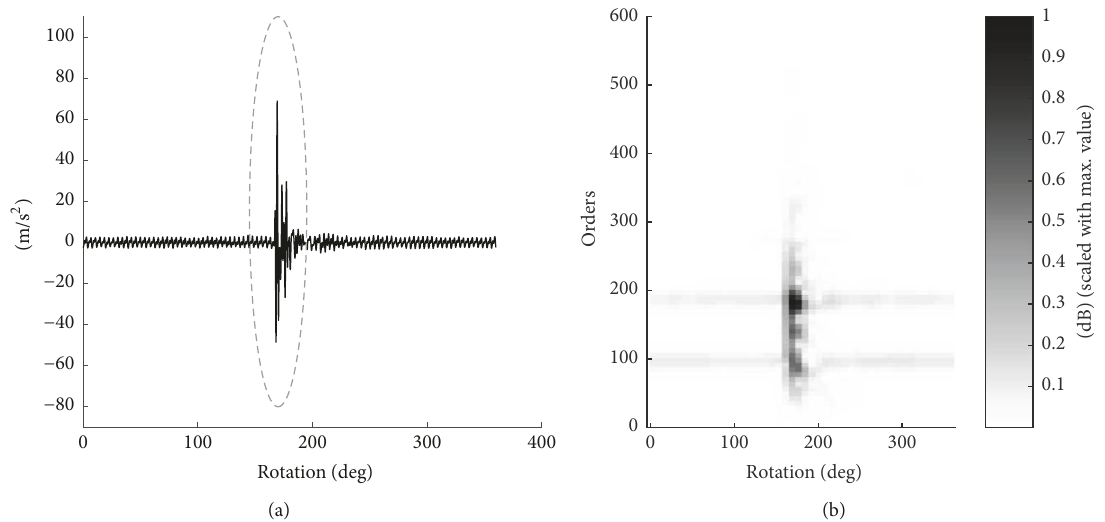
Figure 18: (a) Time Synchronous Average related to the intermediate shaft of Case 2 (the dashed circle highlights the impulsive signal component due to the damaged tooth engagement) and (b) the related spectrogram ( 225 samples of window length and 75 %